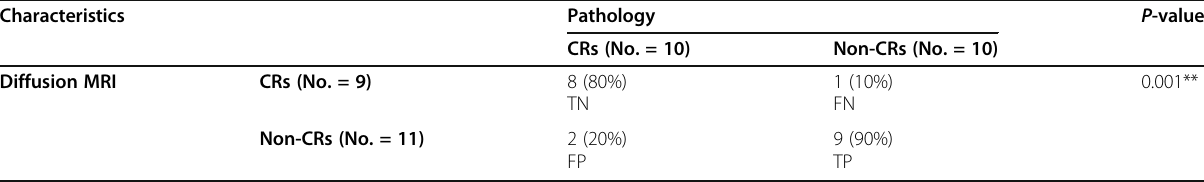
Table 3 DW MRI versus pathology in the studied group Characteristics Pathology Diffusion MRI